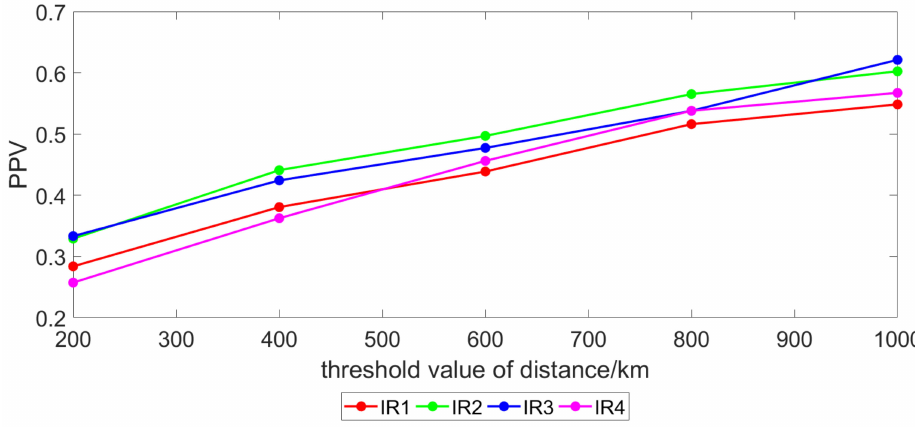
Figure 5. Positive predictive values in different channels at different distance thresholds.